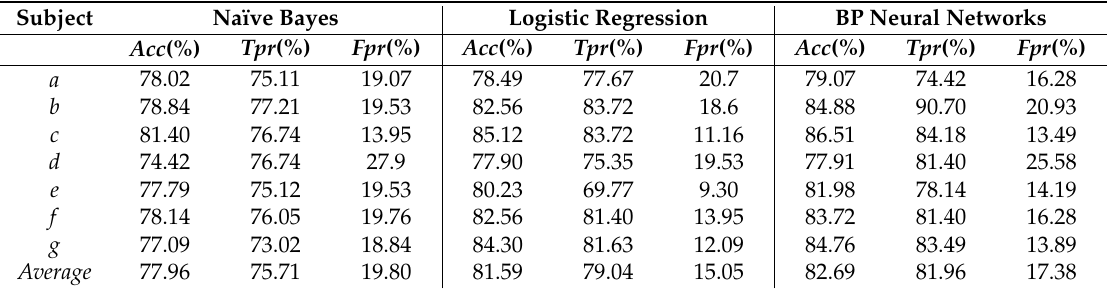
Table 4. The classification results based on the seven-feature set (Fs1). ACC: accuracy rate, TPR: true positive rate, FPR: false positive rate.